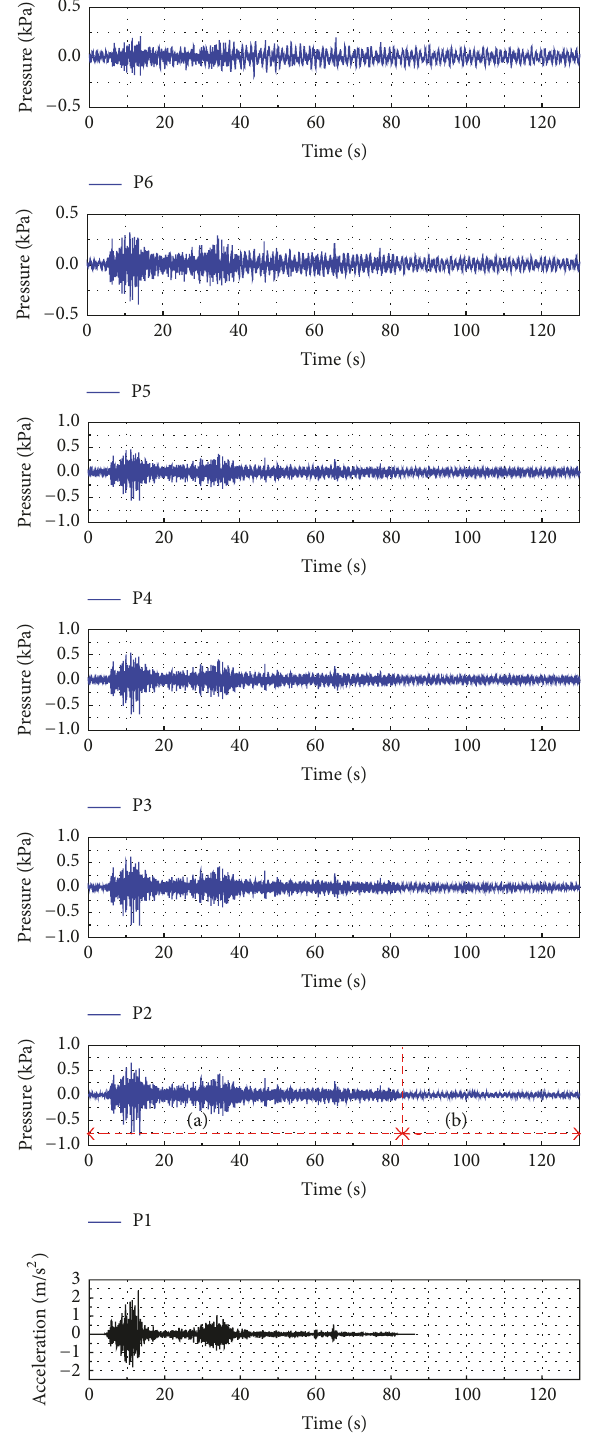
Figure 6: Fluctuations in the hydrodynamic pressures at sensors P1–P6 and the 0.25 g acceleration results with respect to time due to the Wolong earthquake waveform (EQ1). respect to time. As discussed earlier, the pressure recorded at P6 was also affected between the sensor and the surface